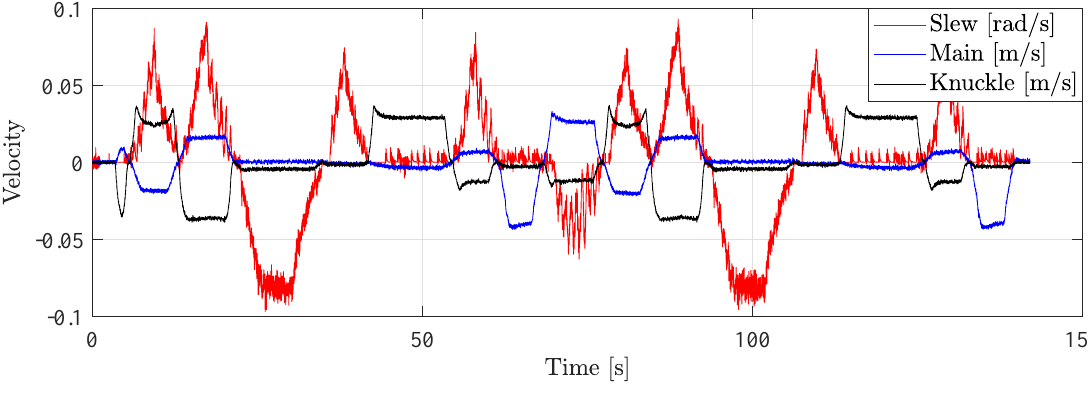
Figure 17. Velocity from laboratory